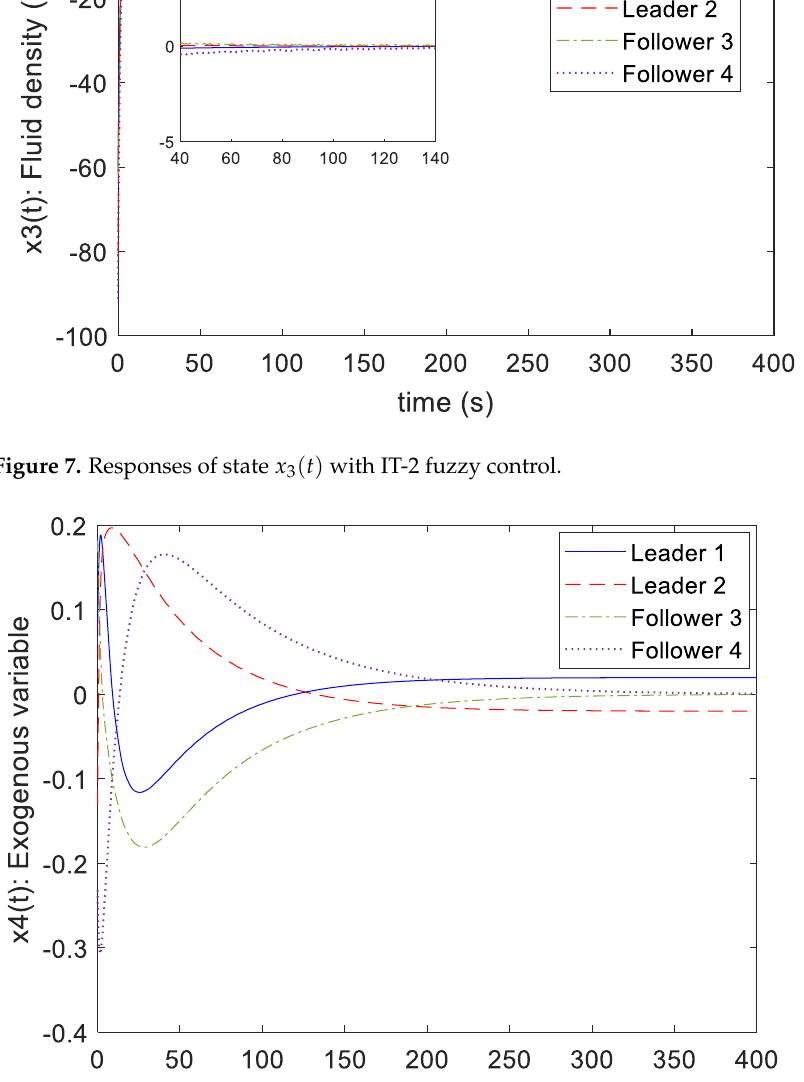
Figure 8. Responses of state x ( t ) with IT-2 fuzzy control. To demonstrate the effectiveness of the proposed design method for the control of the nonlinear multi-boiler system (1)–(8), which consists of uncertainties in every agent, the essential fuzzy control and robust fuzzy control based on the type-1 T–S fuzzy model are presented as follows for the